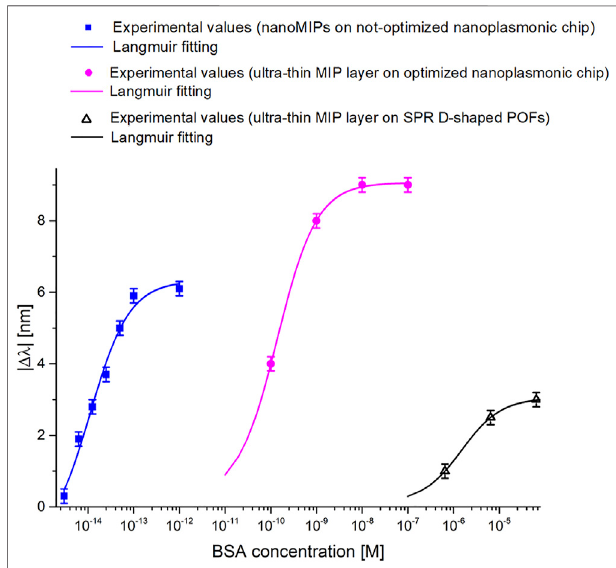
FIGURE 9 | BSA dose-response curves obtained by different sensing approaches based on the combination of plasmonic probes and biomimetic receptors.